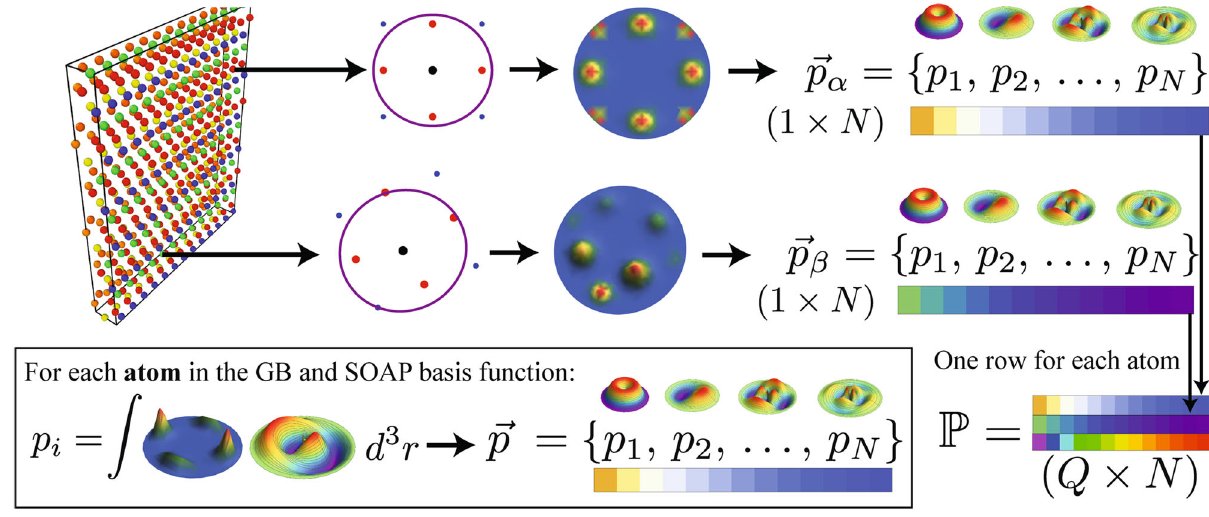
Fig. 1 Illustration of the process for extracting a SOAP matrix P for a single GB. Given a single atom in the GB, we place a Gaussian particle density function at the location of each atom within a local environment sphere around the atom. Next, the total density function produced by the neighbors is projected into a spectral basis consisting of radial basis functions and the spherical harmonics, as shown in the boxed ! for the atom, the magnitude of which is represented in the region. Each basis function produces a single coef fi cient p i in the SOAP vector p fi gure by the colors of the arrays. Once a SOAP vector is available for all Q atoms in the GB, we collect them into a single matrix P that ! represents the GB. A value of N = 3250 components in p is representative for the present